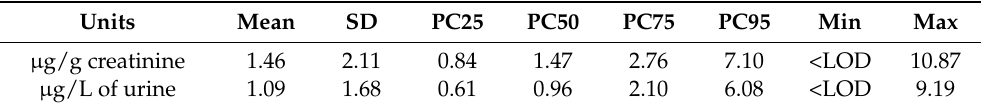
Table 1. The 1-hydroxypyren urinary concentration of exposed women. The limit of detection (LOD) was 1 nmol/L (0.21825 µ